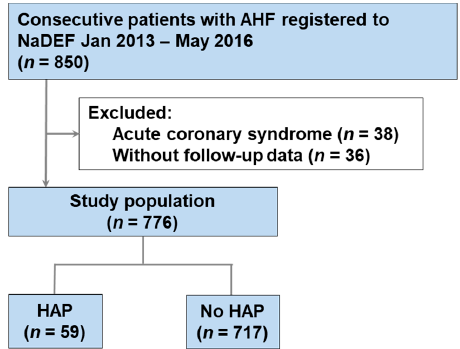
Figure 1. Flow diagram of the study. AHF—acute heart failure; NaDEF—National Cerebral and Cardiovascular Center Acute Decompensated Heart Failure; HAP—hospital-acquired pneumonia.